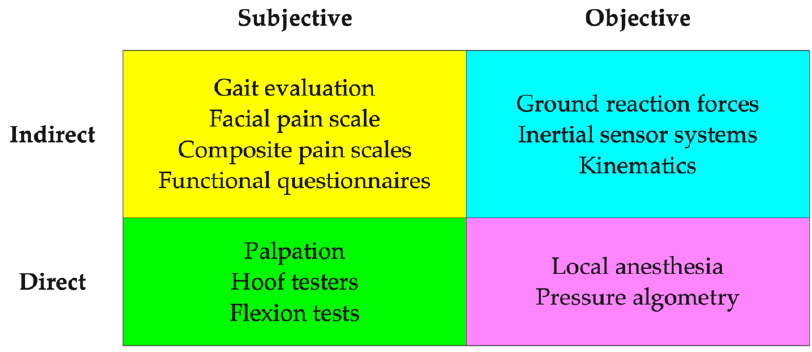
Figure 1. Categorization of methods used for pain detection.